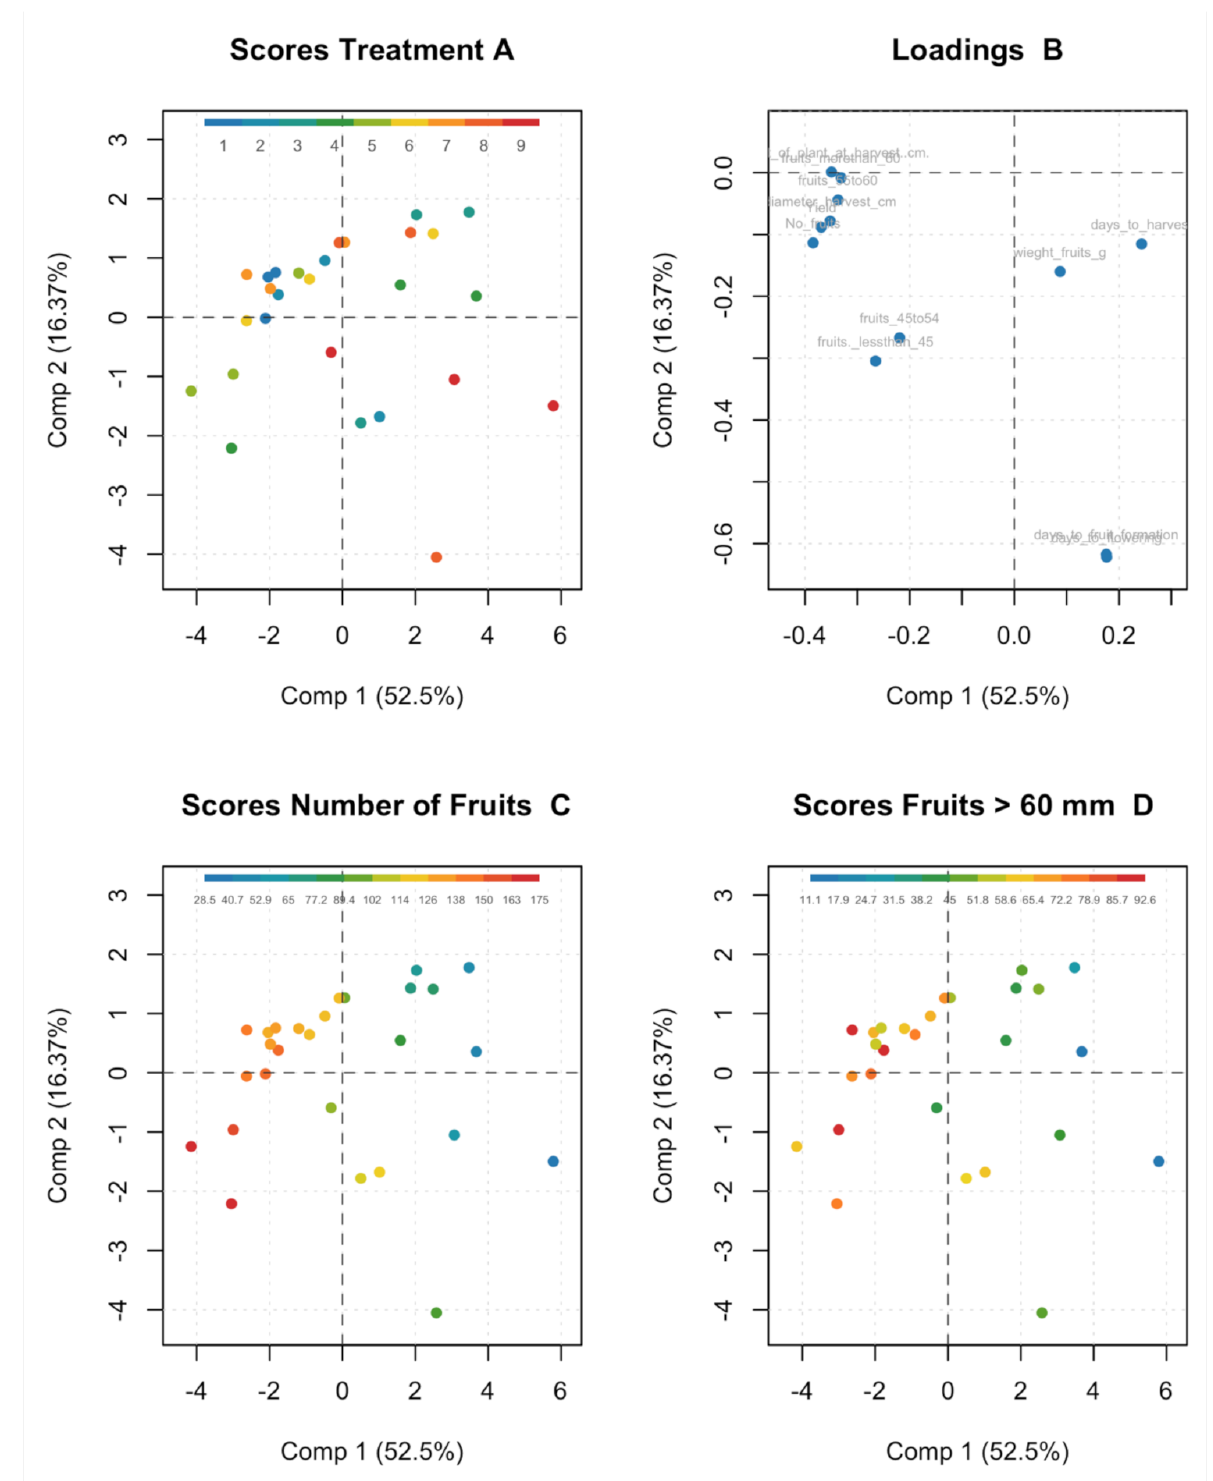
Figure 2. Principal component analysis on naranjilla fruit at 16 de Agosto environment. Panel B is the loading plot and panels A to D the score plots. The principal component 1 and 2 are plotted in panel A and B showing the fertilization practices and the corresponding variables. Panels C to D provide a representation of the score plot colored with respect to the amount of a given variable (from low to high). Treatments 1 to 9. (1) full treatment with all macronutrients (N, P, K, Ca, Mg, and S), (2) a full treatment without nitrogen ( − N), (3) a full treatment without phosphorus ( − P), (4) a full treatment without potassium ( − K), (5) a full treatment without calcium ( − Ca), (6) a full treatment without magnesium ( − Mg), (7) a full treatment without sulfur ( − S), (8) no nutrients applied plus lime (Control +lime) and (9) no nutrients applied without lime (Control −